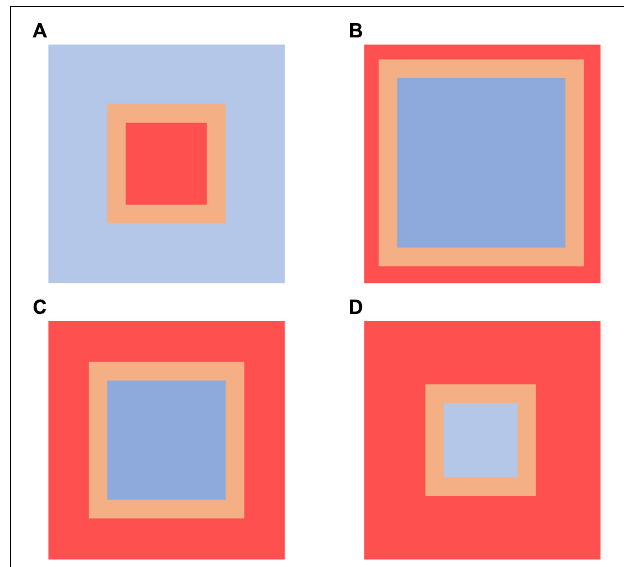
FIGURE 2 | 128 × 128 cell grid seafloor disturbance model with varying extents of benthic protection (blue cells, protected areas; orange cells, impacted areas classified as edge; red cells, impacted areas). (A) 75% of model protected; (B) 50% of model protected; (C) 25% of model protected; (D) 10% of model